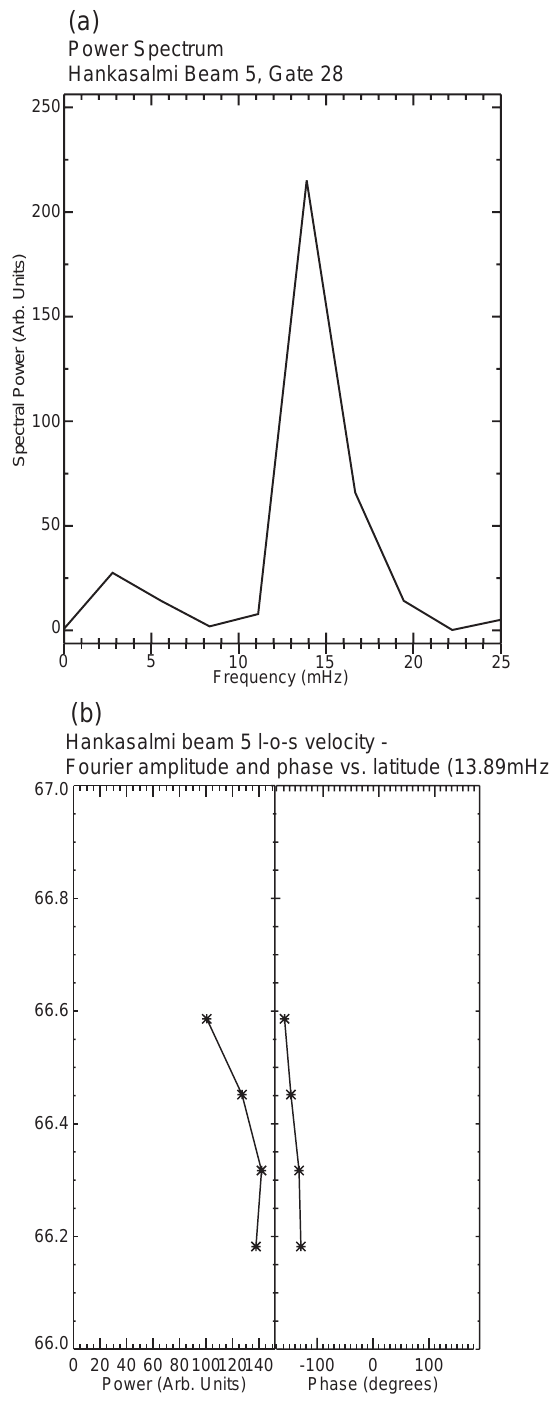
Fig. 4 Fig. 4. (a) Fourier power spectrum, (b) magnetic latitude profile of Fourier power and phase at 13.9mHz over the same